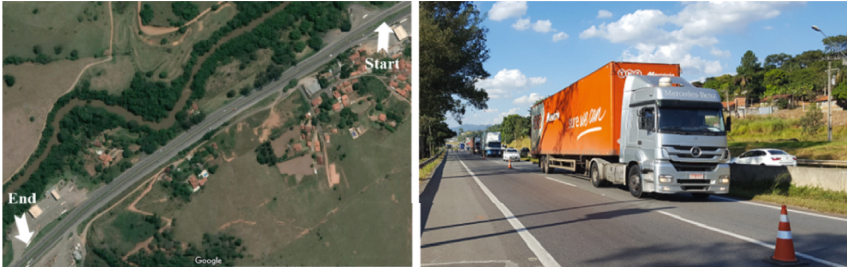
Figure 1: Location of experimental sections (source: Google Maps) and section view.